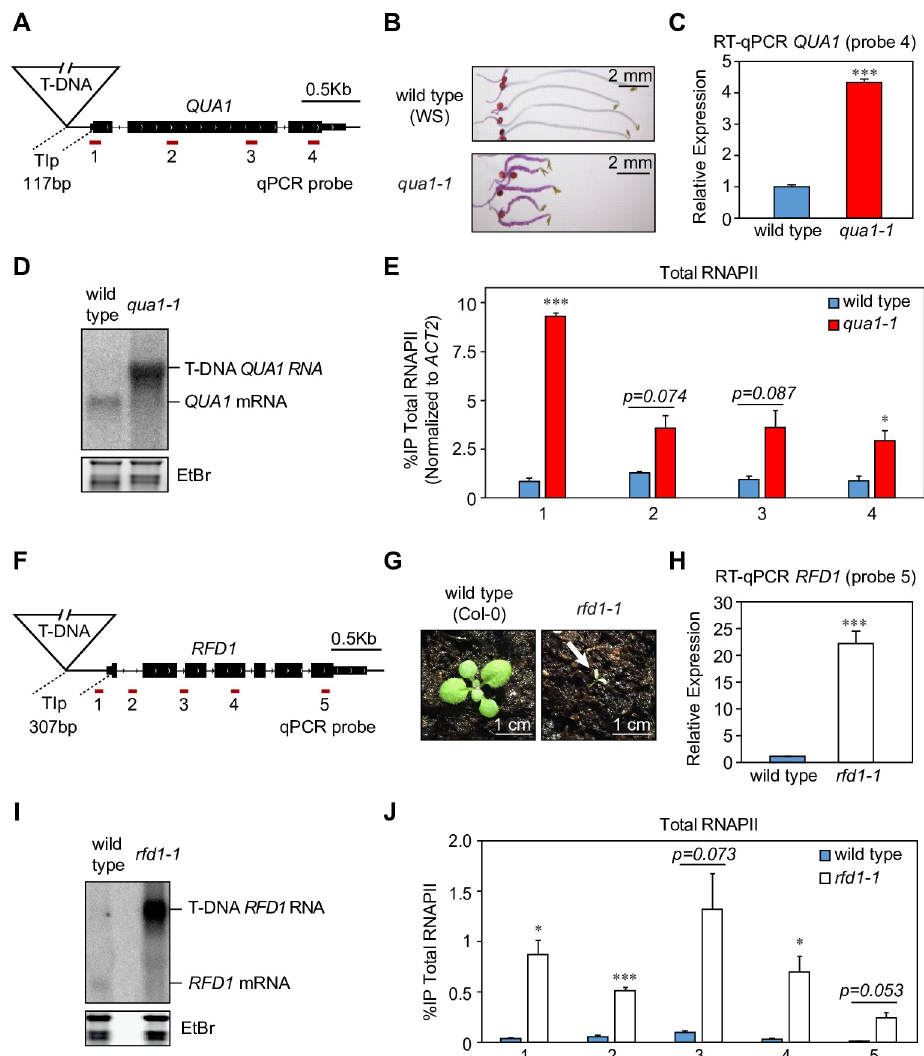
Fig 1. Upstream transcription from within T-DNA represses downstream gene expression. (A) Schematic representation of the qua1-1 locus, including primer pair positions (probe 1–4) for qChIP and RT-qPCR. TIp denotes Transcriptionally Interfered promoter region remaining in the qua1-1 mutant. (B) Ruthenium red staining of wild type (ecotype WS) and qua1-1 hypocotyls. (C) Quantitative analysis of QUA1 transcript levels in wild type and qua1-1 by RT-qPCR using primer pair 4 (See Panel A, qPCR probe 4). (D) Analysis of QUA1 transcripts in wild type and qua1-1 by northern blotting. Ethidium bromide (EtBr) staining of ribosomal RNA is used as a control to assess relative equal loading and RNA quality. (E) qChIP for total RNAPII levels across QUA1 in wild type and qua1-1 . Note: For comparisons between wild type WS and qua1-1 , qChIP values were normalized to reference gene ACT2 in order to control for differential fixation conditions between samples (See methods for more details). (F) Schematic representation of the rfd1-1 locus, including primer pair positions for qChIP and RT-qPCR (probes 1–5). TIp denotes Transcriptionally Interfered promoter region remaining in the rfd1-1 mutant. (G) Photo-bleaching phenotype of rfd1- 1 seedlings grown in high light conditions (ecotype Col-0). (H) Quantitative analysis of RFD1 transcript levels in wild type and rfd1-1 by RT-qPCR using primer pair 5 (See Panel F, qPCR probe 5). (I) Analysis of RFD1 transcripts in wild type and rfd1-1 by northern blotting. EtBr staining of ribosomal RNA is used as a control to assess relative equal loading and RNA quality. (J) qChIP for total RNAPII %IP levels across RFD1 in wild type and rfd1-1 . Error bars represent standard error of the mean resulting from three independent replicates. For statistical tests, a single asterisk denotes p < 0.05, two asterisks denote p < 0.01, three asterisks denote p < 0.001 between samples by Student’s t-test.